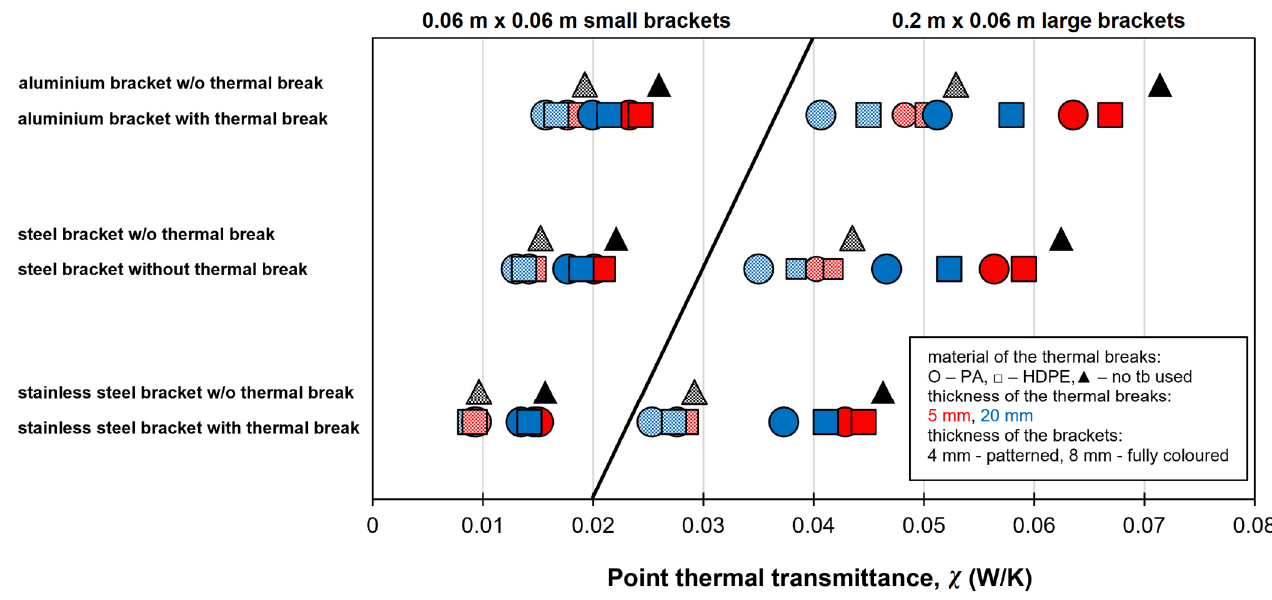
Figure 9. Brackets fixed using a single 5 cm long steel anchor in 20 cm thick reinforced concrete wall with 20 cm thick λ = 0.04 W/(m×K) thermal insulation. with 20 cm thick λ = 0.04 W/(m × K) thermal